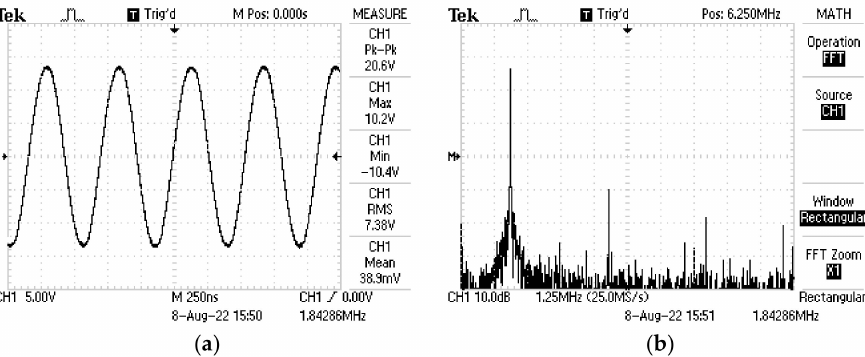
Figure 10. The output waveform of the QO2 at f Q = 1.8432 MHz with L = 10 µ H, C 1 = 820 pF, and C 2 = 8.2 nF: ( a ) the output voltage; ( b ) the output spectrum with sweep along the x -axis from 0 Hz to 12.5 MHz (at 1.25 MHz scale).